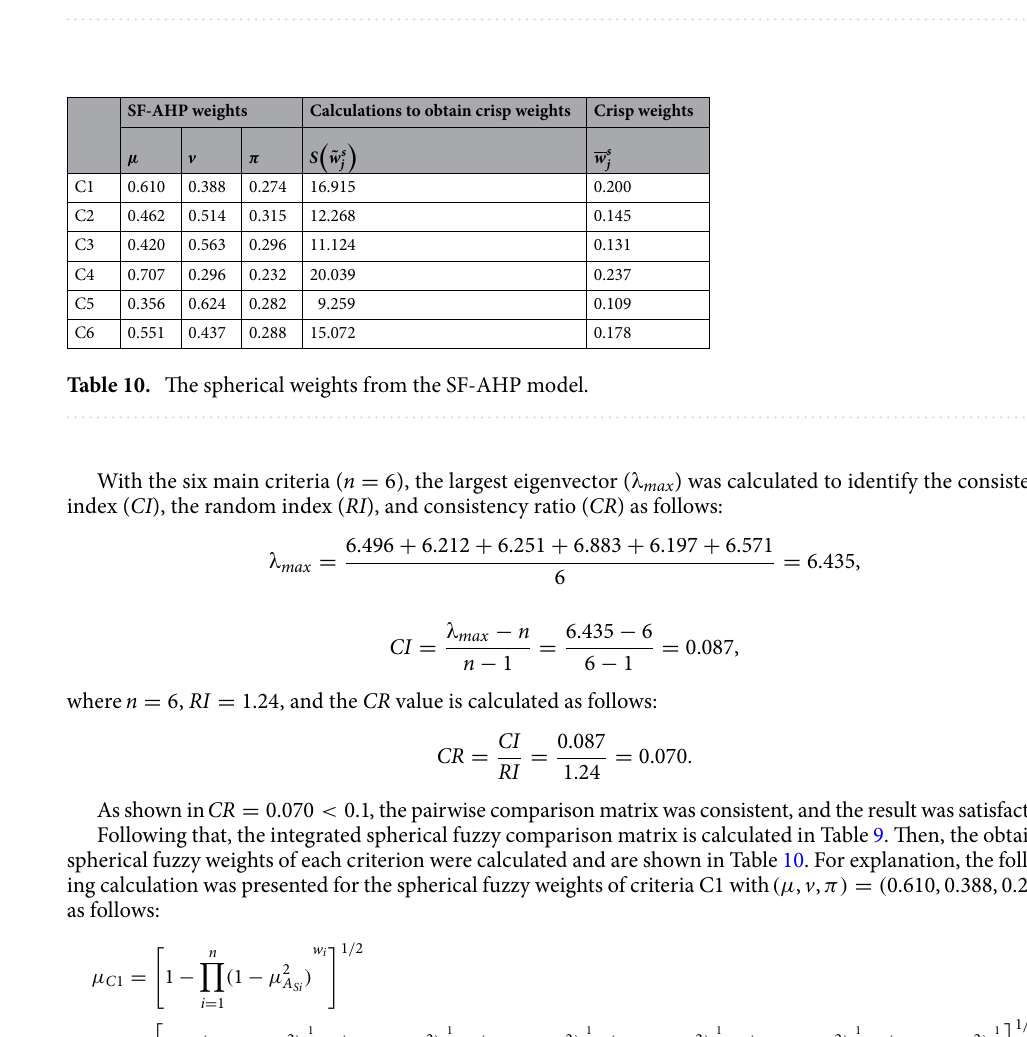
Table 9. The integrated spherical fuzzy comparison matrix.